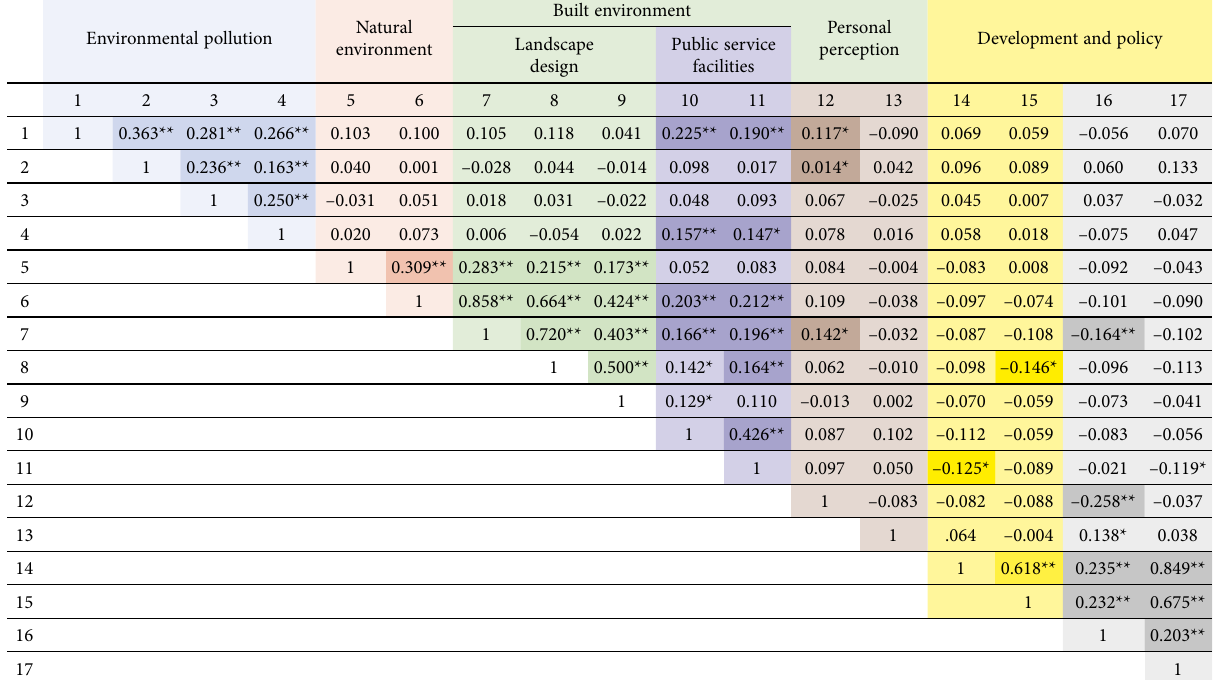
Table 4. Correlation coefficients and significance levels of the environmental quality factors, where the digital codes are shown in Table 2 and Table 3. Envi ron men tal pollu